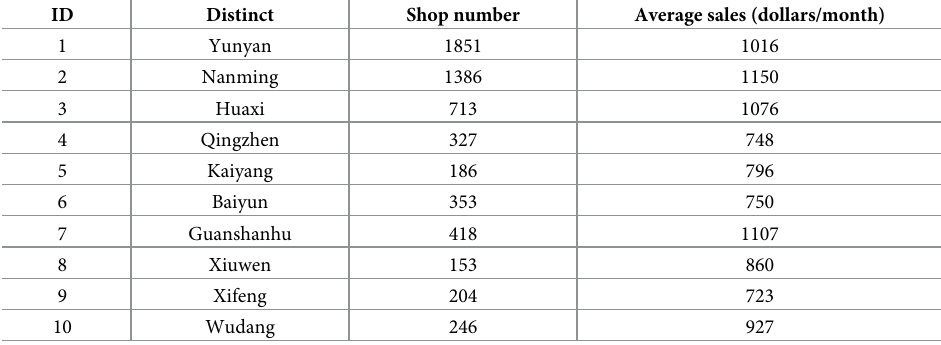
Table 2. Information of retail shops in each